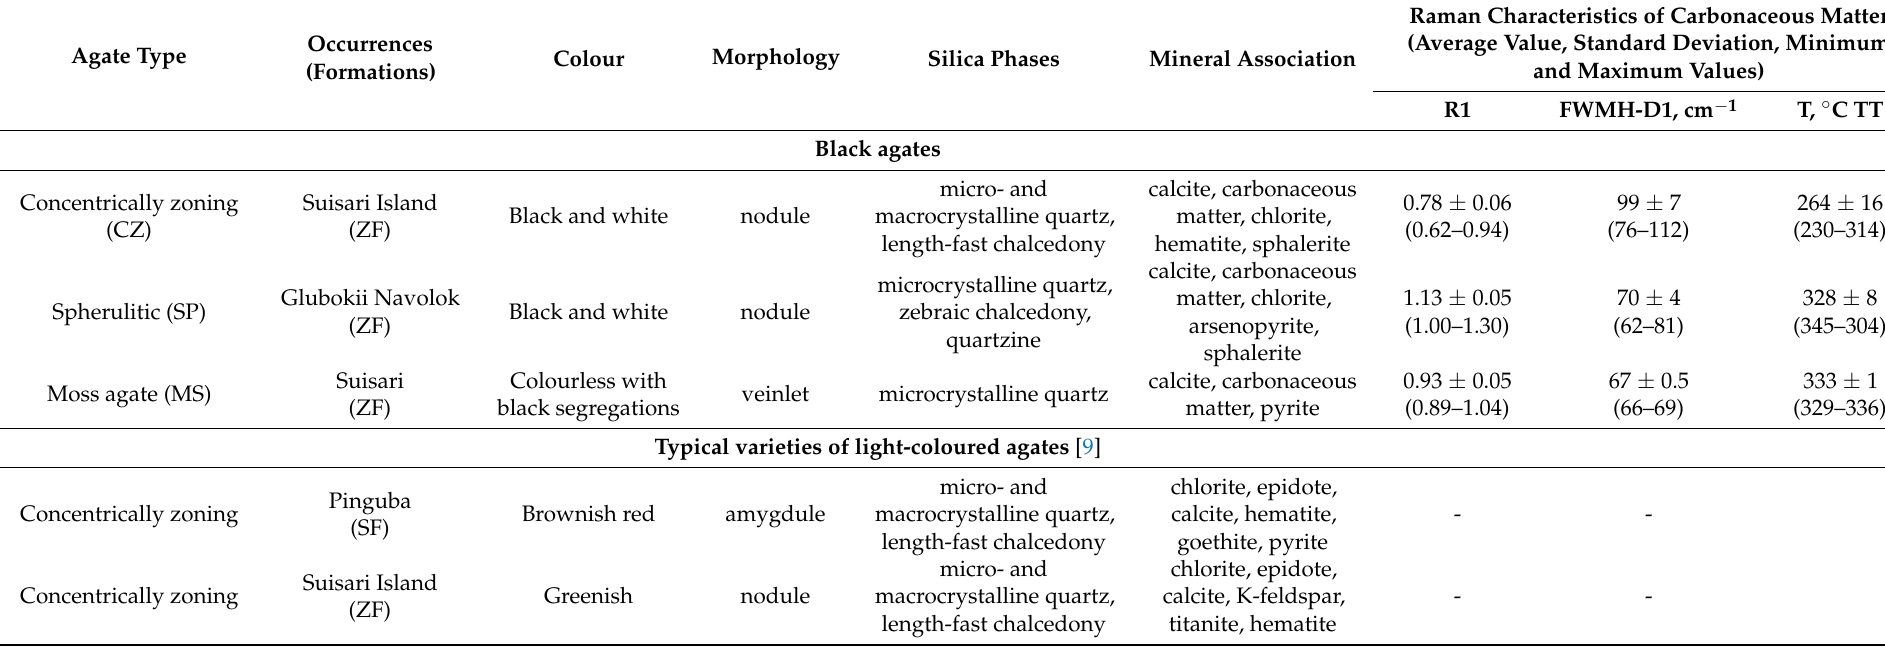
Table 2. Summary of morphology, textures, and mineral composition of black- and light-coloured agates from Paleoproterozoic volcanics, Onega